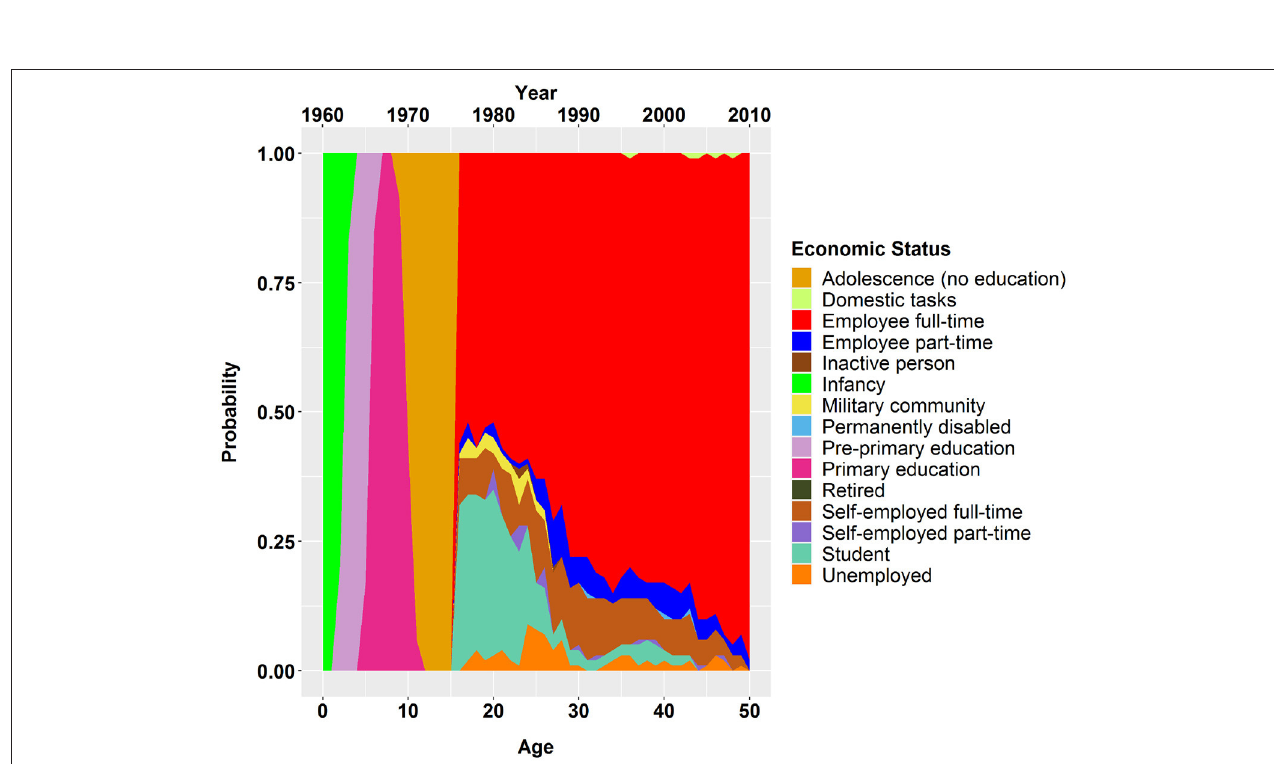
FIGURE 3 | Life course trajectory of a German, male, full-time employee, age of 50 in 2010.